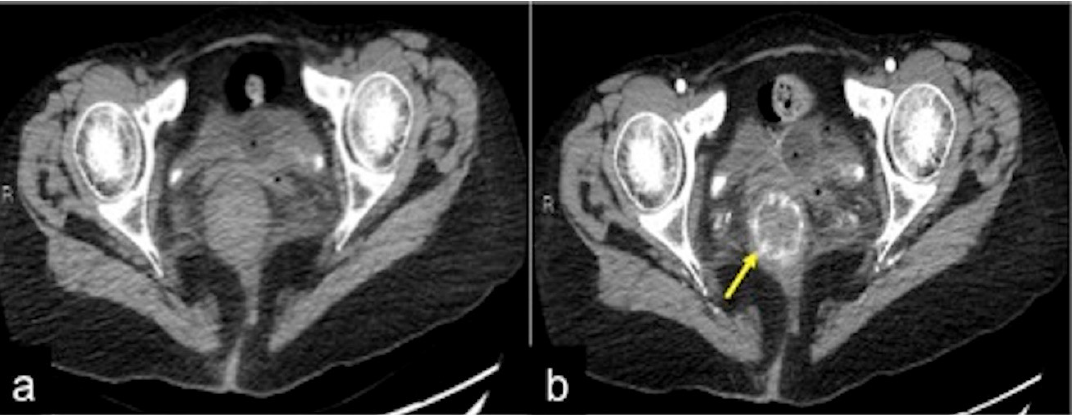
Figure 42. CTA multiphasic study of rectal bleeding during treatment with VEGF inhibitors. The pre-contrast ( a ) and arterial ( b ) phases show the presence of bleeding in the rectal wall ( b , arrow) of a patient treated with Bevacizumab.